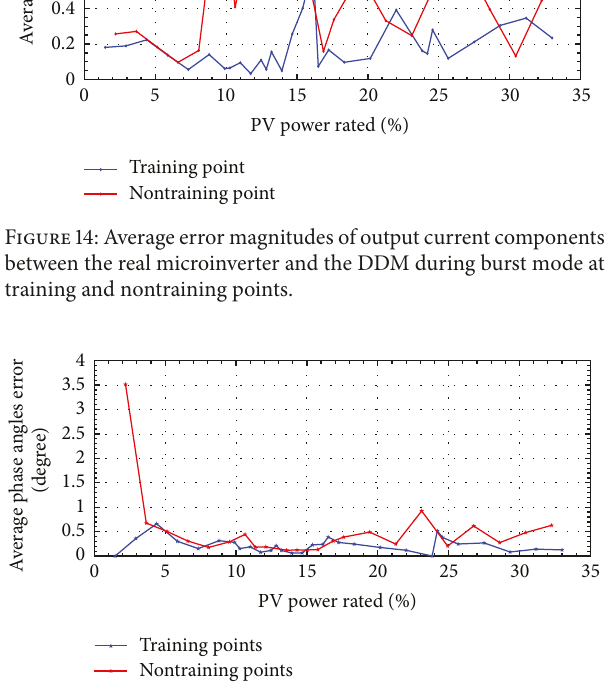
Figure15:Averagephaseangleserrorofoutputcurrentcomponents between the real microinverter and the DDM during burst mode at training and nontraining